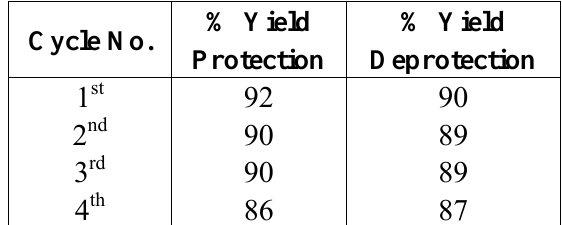
Table 4. Aldehyde protection-deprotection reactions in the presence of reactivated sulphated